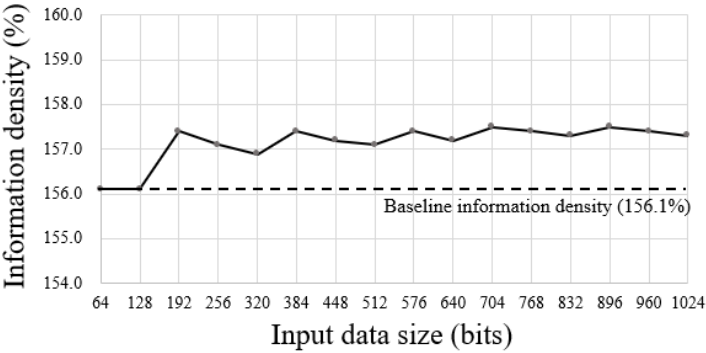
Figure 8. Storage density variation of 3LC PCM using proposed method for integer multiples of 64-bit data blocks.